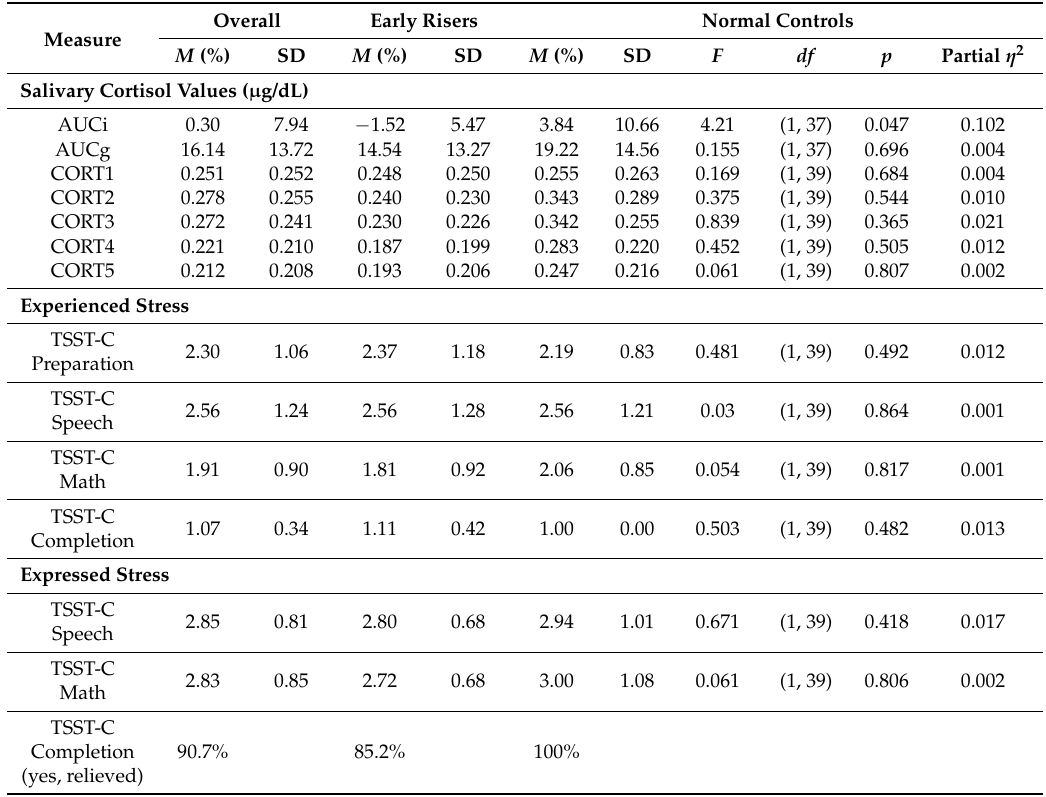
Table 2. Salivary cortisol, ratings of experienced and expressed stress prior to, during, and following the Trier Social Stress Test—Child Version at Year